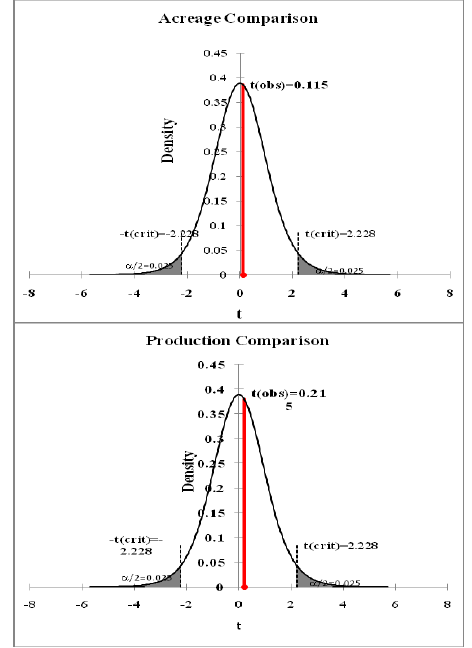
Figure 13: Normally distributed t-curve for state-level comparison of DES and FASAL R&M estimates (2017-18) Estimates